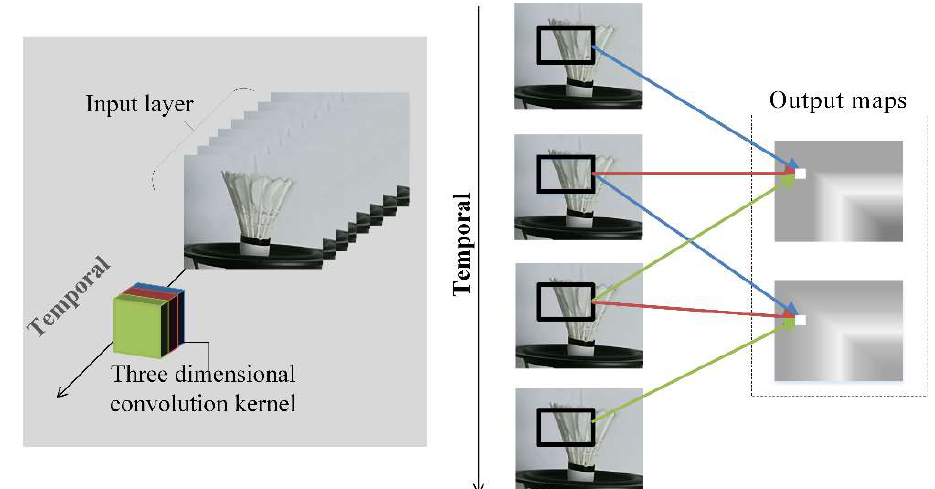
Figure 3. Feature with a kernel from the RGB video stream in temporal.